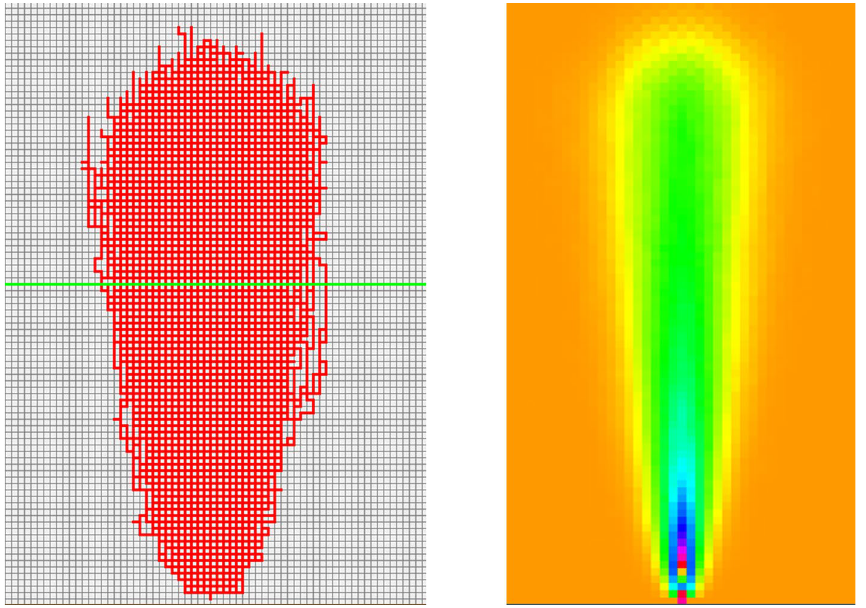
Figure 10. Random walker #1 simulated